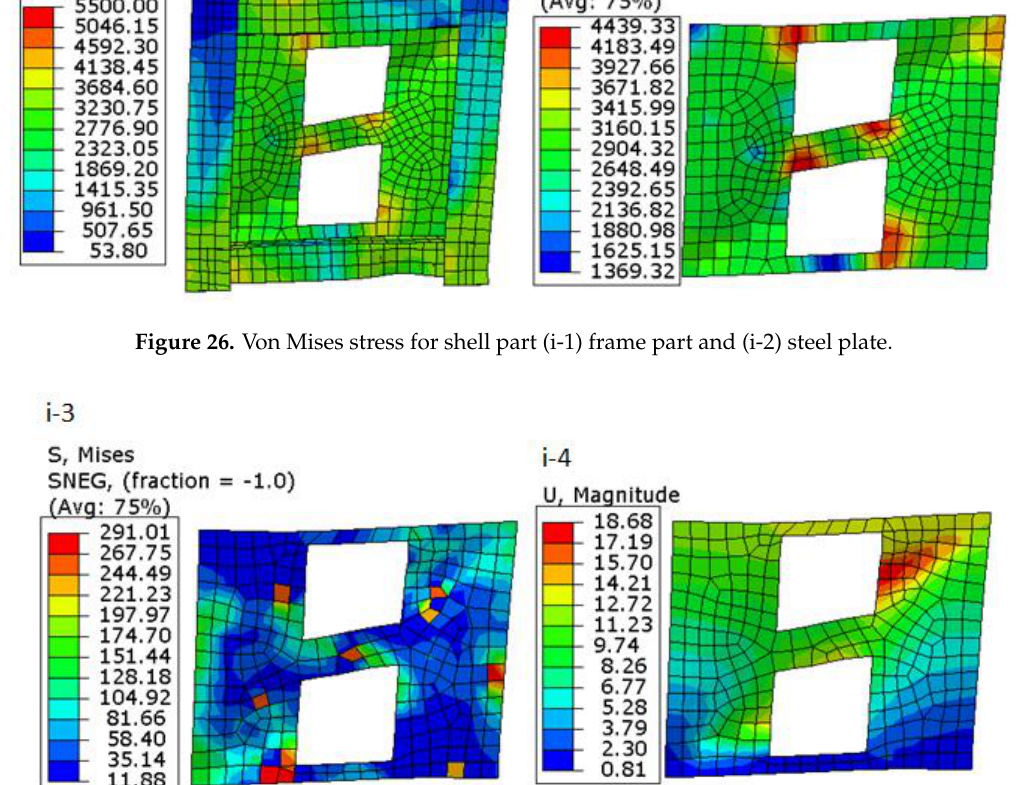
15 of 27 Figure 24. Von Mises stress for shell part (h-1) frame part and (h-2) steel plate.